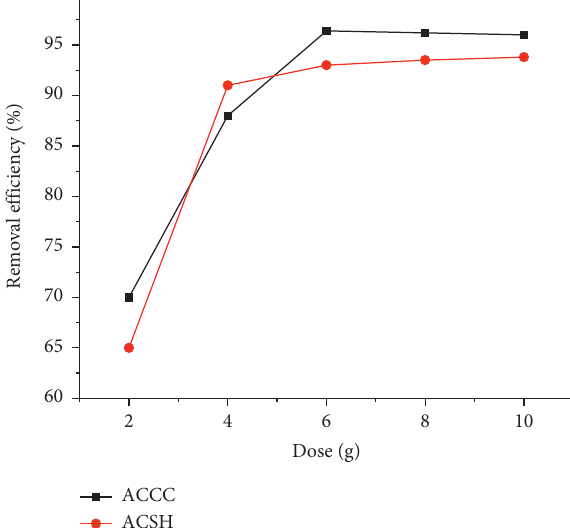
Figure 6: Effect of particle sizes on adsorption efficiency of acti- vated carbon of corncob, and sorghum husk (dose � 6g), rpm � 250, and 5.0mg/L